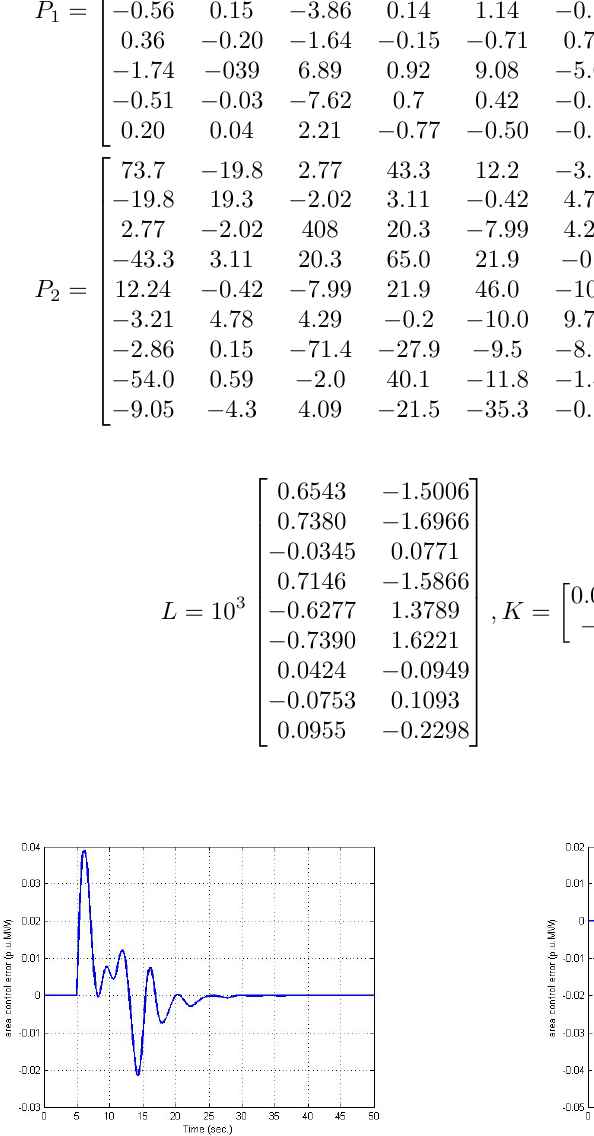
is chosen to be as d=d(t)=0.1s. The step load disturbances are applied as + 0.02 p.u. for area 1 at 5 s, +0.02 p.u. for area 2 at 10 s. The uncertain parameters in the two-area power